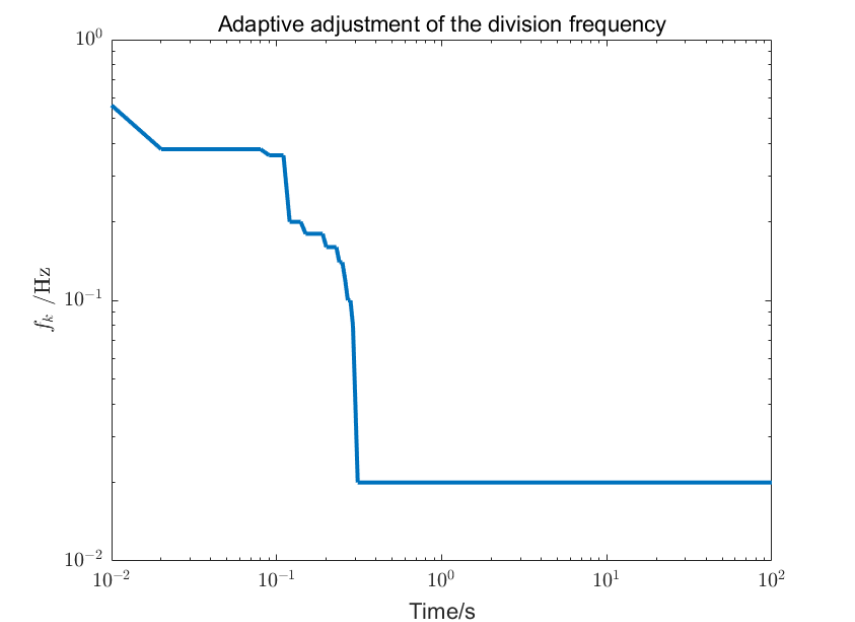
Figure 8. Adaptive adjustment of the frequency division. f k represents the frequency division point. A frequency division point search method based on minimizing the cost function of the spacecraft and the telescope was used to adjust f k